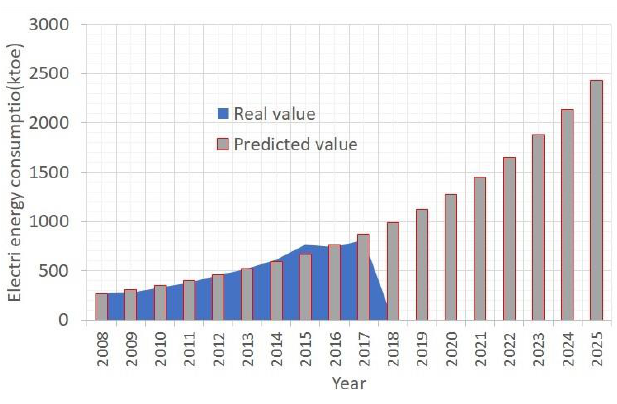
Fig. 1. Ethiopian electric energy utilization